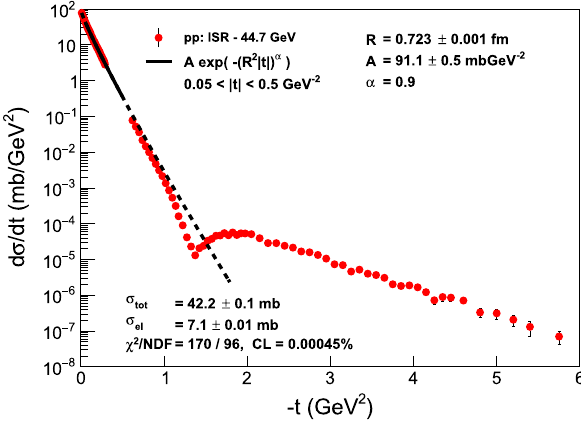
Fig. 38 Zeroth-order Lévy fits to the cone region of the differential cross-section data on pp elastic scattering at with fixed α = 0 . 9, A and R being free fit parameters